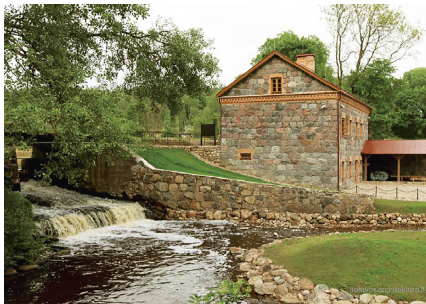
Figure 3: Liubavas mill-museum (source: https://lt.wikipedia. org/wiki/Liubavo_dvaras).